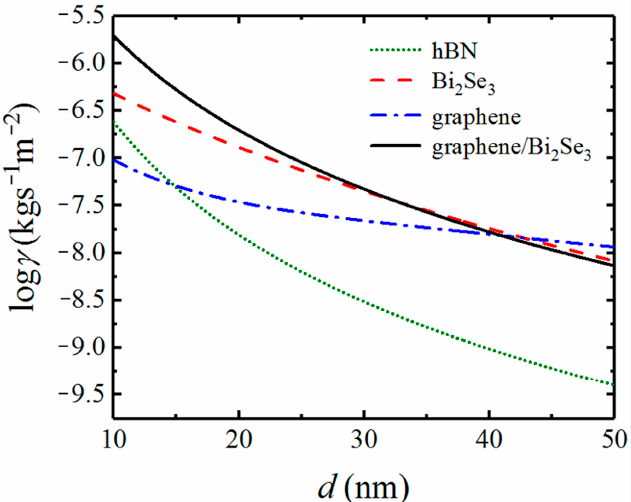
Figure 3. The dependence of Casimir friction coefficients for different configurations on separation distance d . The chemical potential of graphene is 𝜇 = 0.2 eV. The base of the logarithm is 10 in this and the following figures.